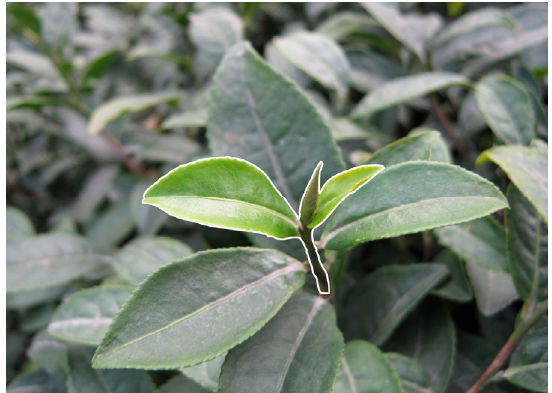
Figure 4. Segmentation of